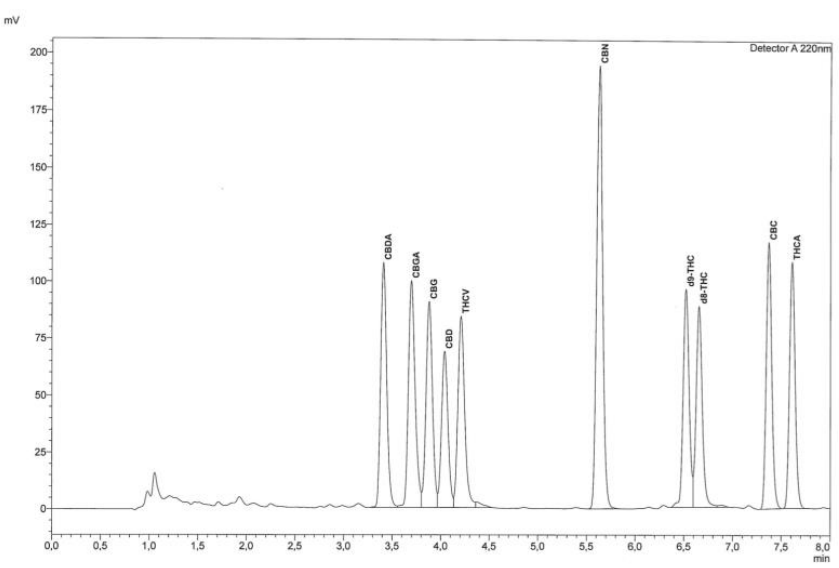
Figure 1. Chromatographic trace of a standard cannabinoid mixture analyzed by RP-HPLC-UV equipped with reverse phase C18 column.